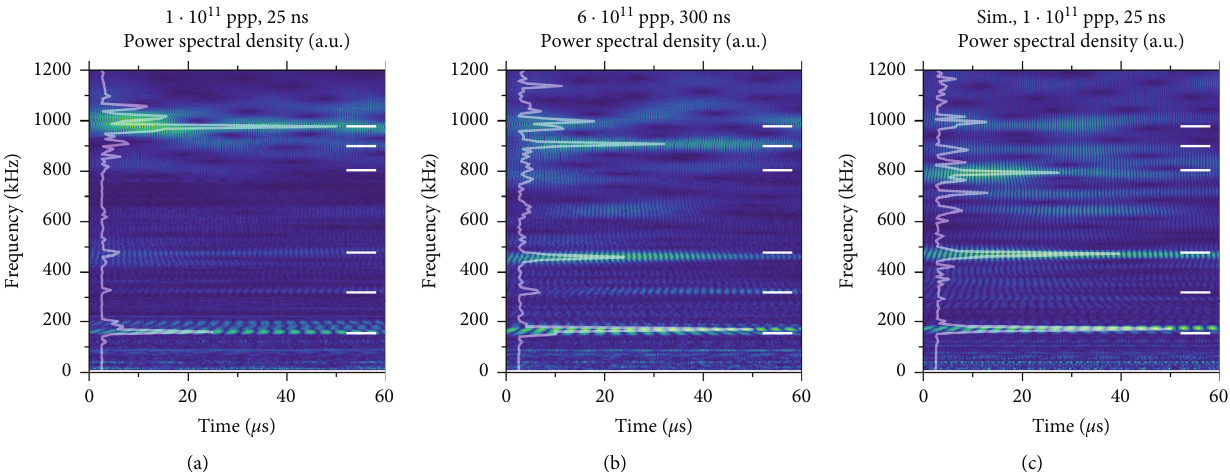
Figure 10: Continuous wavelet transformation of the radial surface velocity obtained in the experiment and by simulation for sample #1 SGL R6650. The normalized power spectral density plot is overlaid in light grey. Solid white lines indicate vibration modes of the target geometry obtained by modal analysis. Experimental result at 1 × 10 11 ppp (a), 6 × 10 11 ppp (b), and simulation result at 1 × 10 11 ppp